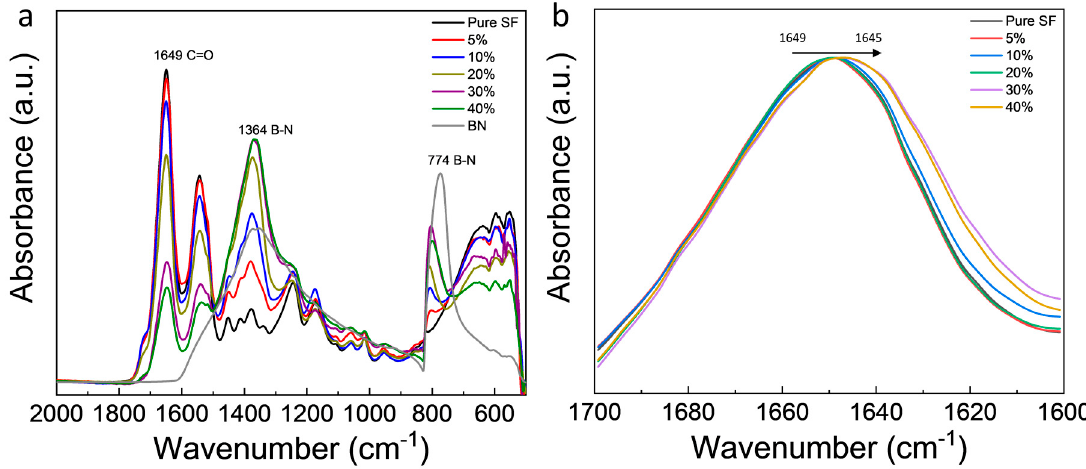
Figure 2. Fourier transform infrared spectroscopy (FTIR) spectra of ( a ) electrospun pure SF and BNSF nanofibers and raw BN sheets; ( b ) the amide I region of pure SF and BNSF nanofibers.